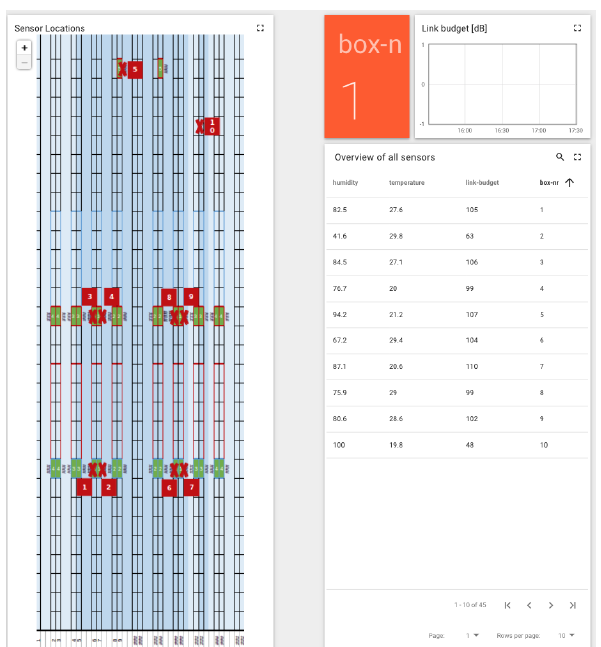
Figure 11. Overview of sensor box and its location in the greenhouse.